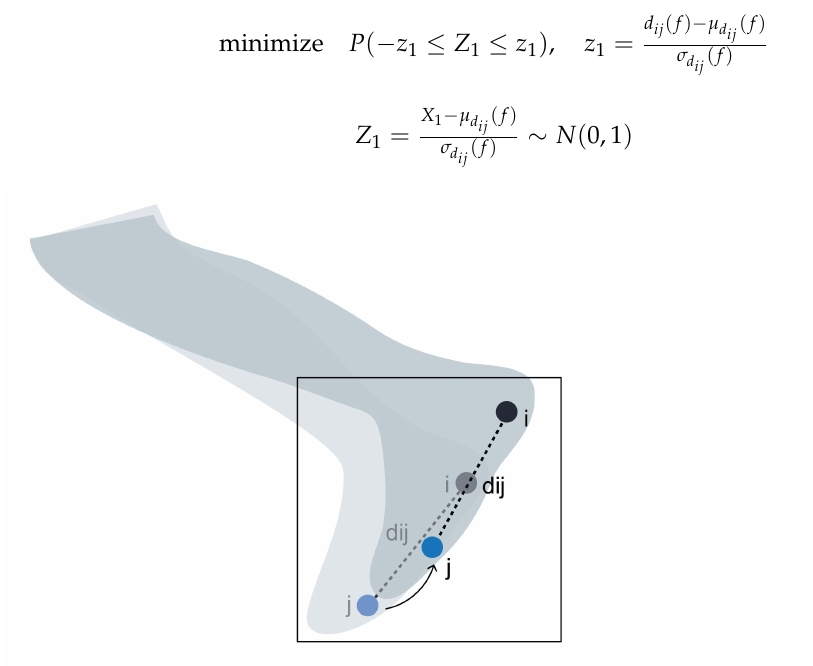
Figure 1. Example of markers which maintain a (roughly) constant distance throughout a trajectory.